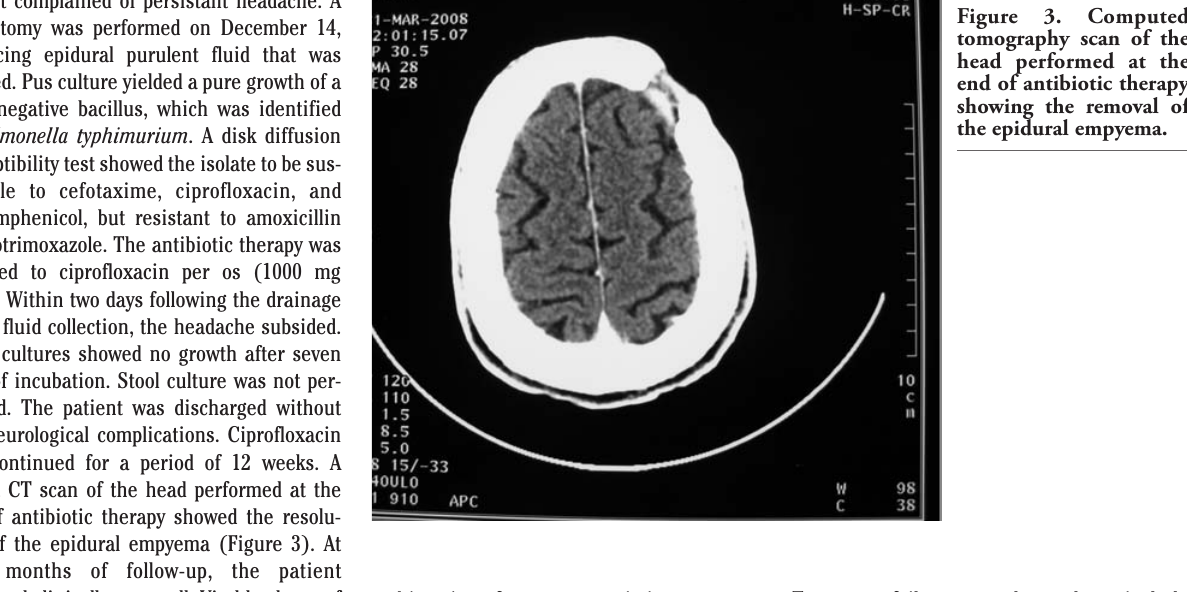
head performed at the end of antibiotic therapy showing the removal of the epidural